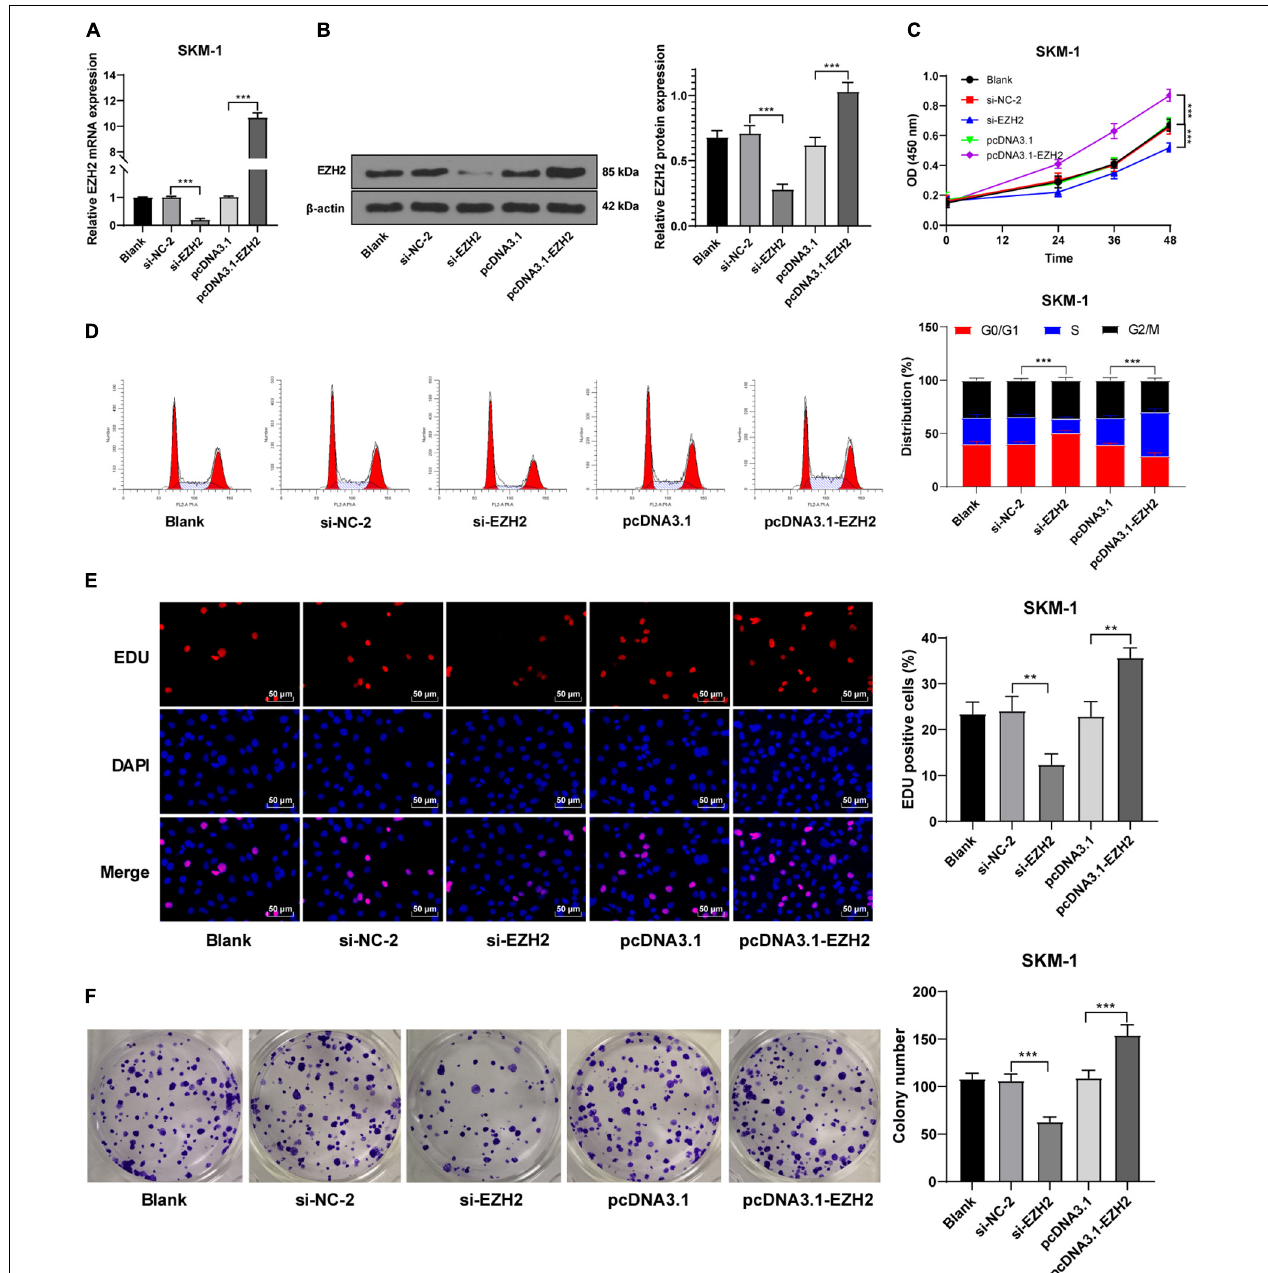
FIGURE 3 | Silencing EZH2 expression inhibited SKM-1 cell proliferation. (A,B) Transfection efficiency of si-EZH2 or overexpression of EZH2 was confirmed using RT-qPCR and Western blot; (C) Viability of SKM-1 cells under different treatments was measured using CCK-8 assay; (D) Cell cycle of SKM-1 cells was detected using flow cytometry; (E,F) Proliferation ability of SKM-1 cells was measured using EdU and colony formation assay. The cell experiments were repeated three times. Data are expressed as mean ± standard deviation. Data were analyzed using one-way ANOVA, followed by Tukey’s multiple comparisons test, ** p < 0.01, *** p <